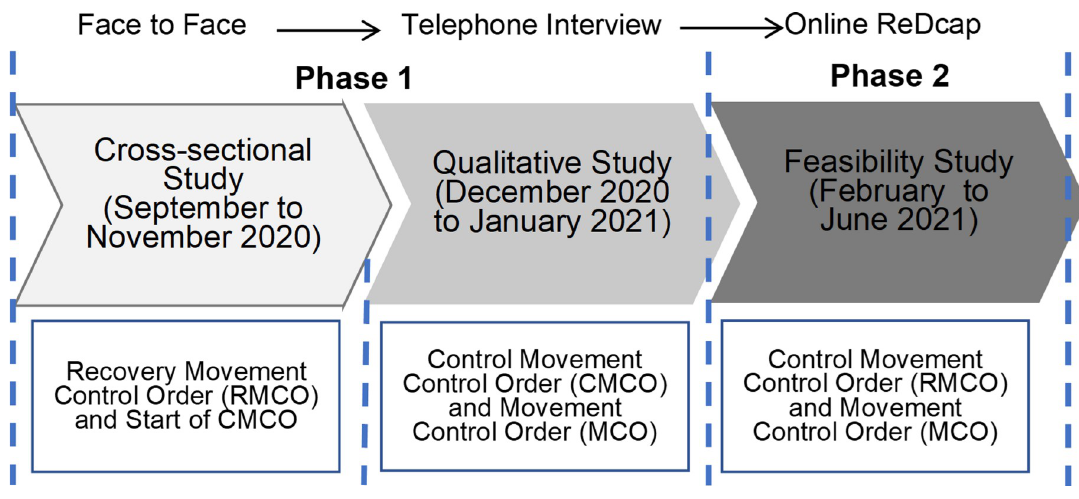
Fig 1. Timeline of each phase of the study and the corresponding movement control.